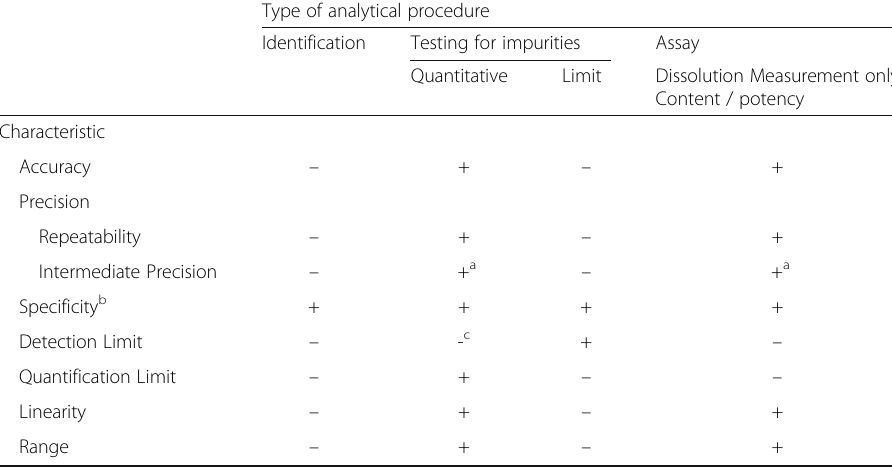
Table 1 Characteristics to be validated following ICH